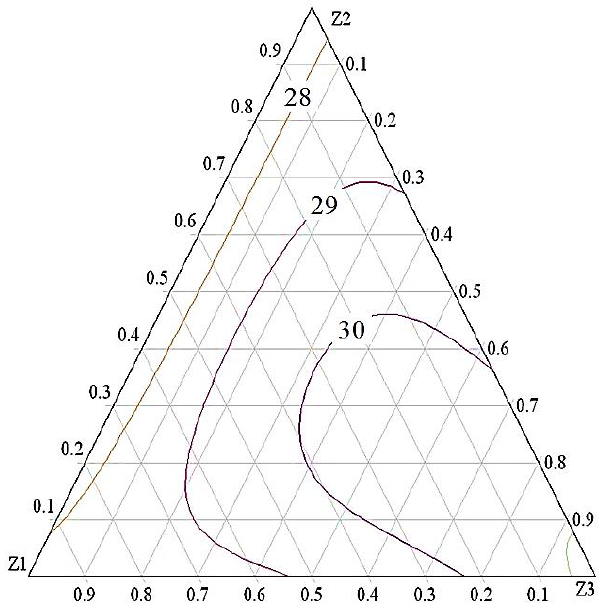
Fig. 8. Isolines of the plastic strength of the jelly mass based on